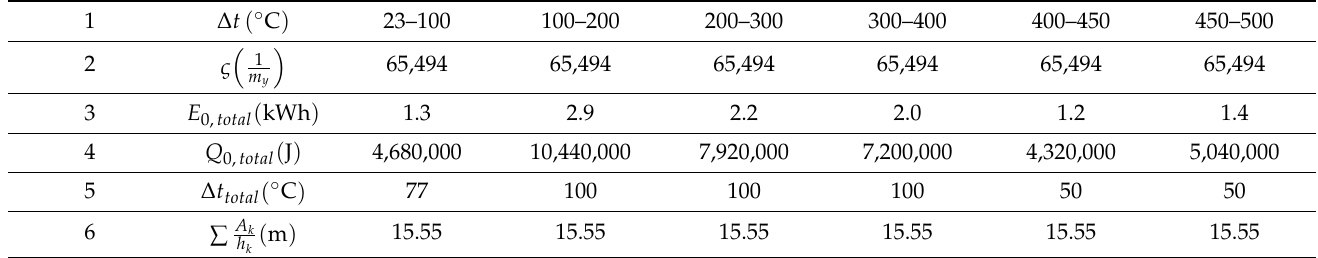
Table A5. Prototype painted—scale